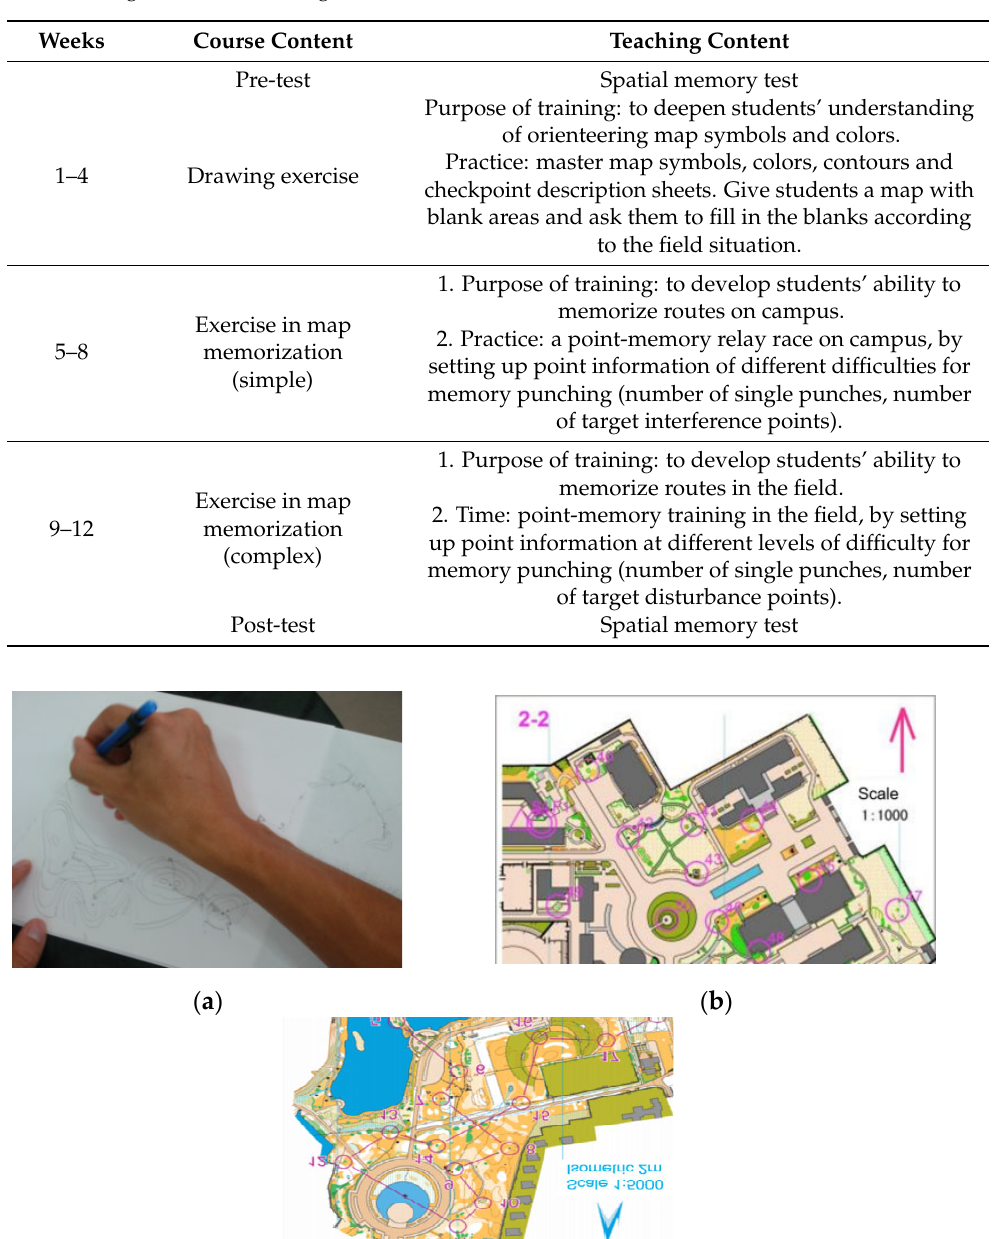
Table 1. Program of orienteering intervention.